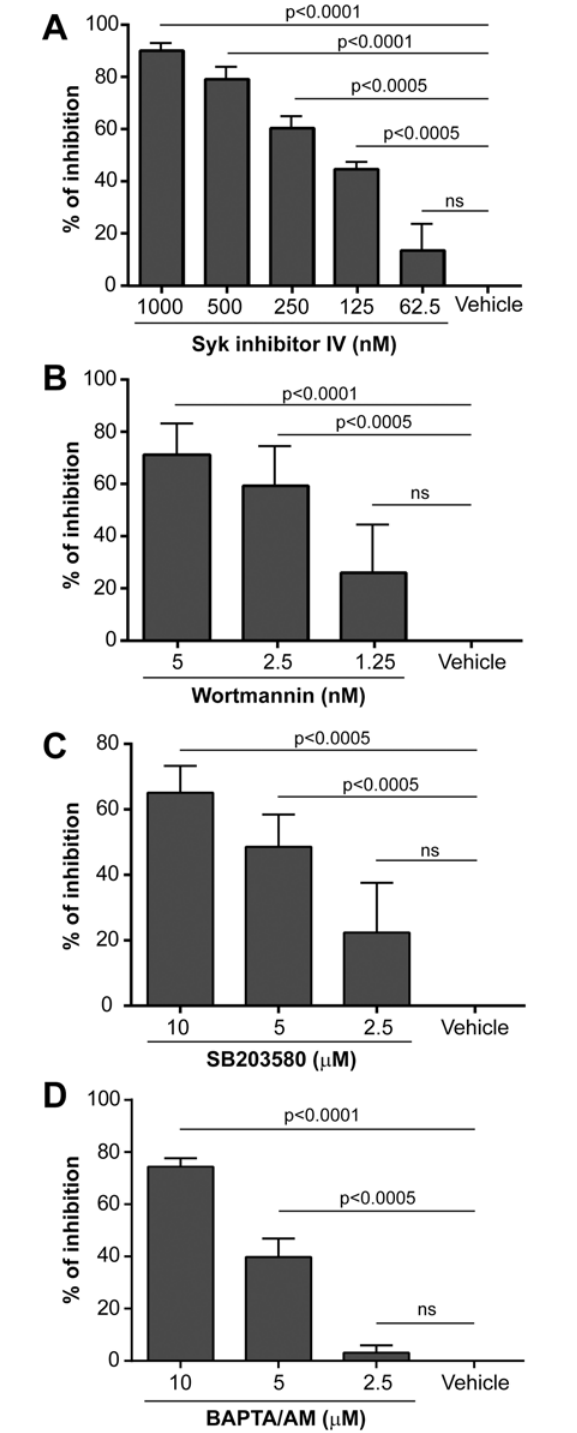
Fig 3. IL-10 secretion depends on p38, PI3K, Syk and calcium mobilization. Purified human B cells were either pretreated for 45 min with the vehicle (used as a control) or increasing concentrations of the listed specific inhibitors. Cells were then incubated overnight with L . infantum amastigotes at a final parasite:host cell ratio of 3:1. Finally, IL-10 production was quantified by ELISA. Results are expressed as means +/- SEM of the percentages of inhibition compared to the vehicle. Statistical significance was evaluated by two-tailed Student ’ s t-test (n = 5 to 7).